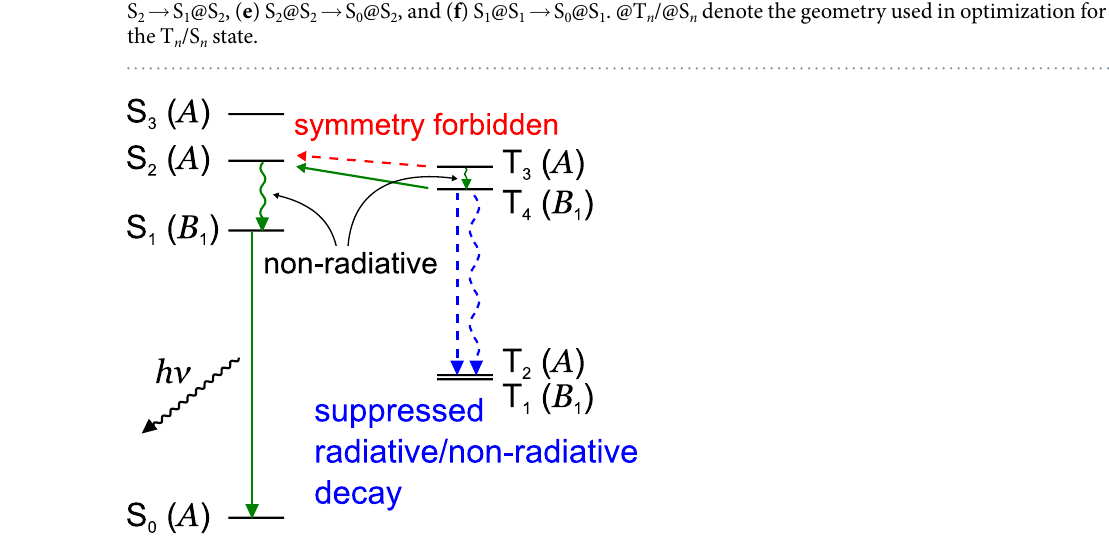
Figure 5. Off-diagonal VCCs of ( a ) T 4 @T 4 → T 2 @T 4 , ( b ) T 4 @T 4 → T 1 @T 4 , ( c ) T 3 @T 3 → T 4 @T 3 , ( d ) S 2 @ S